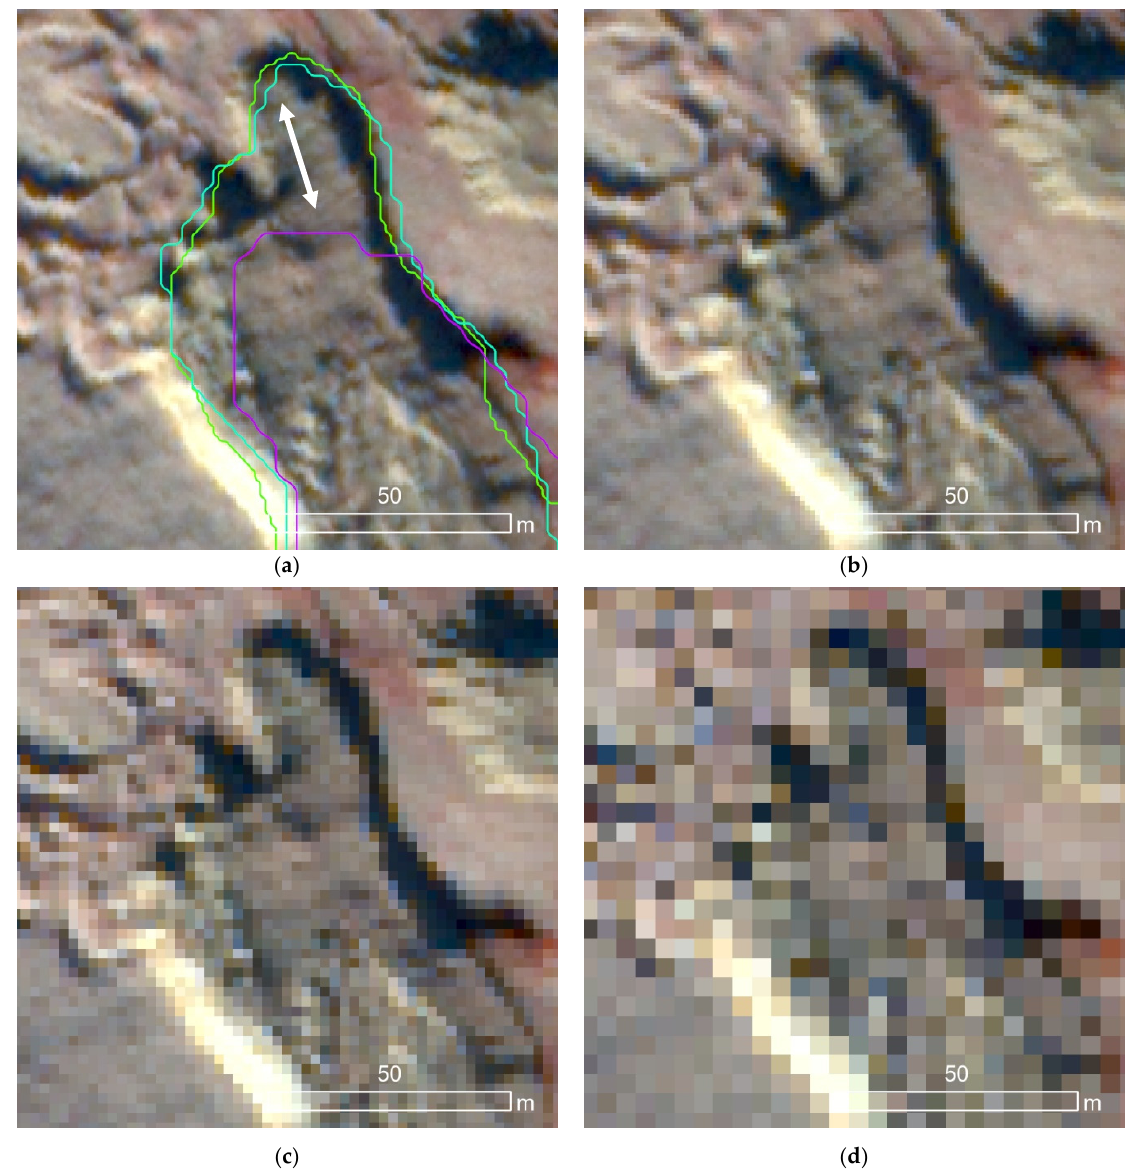
Figure 21. Fluctuation of the model-predicted RTS boundary (here zoomed into headwall of the RTS) with respect to image resizing factor (spatial resolution degradation). ( a ) Model-predicted boundaries when the original image tile (2048 × 2048) is resized to match the network input sizes of 1024 × 1024 (green outline), 512 × 512 (cyan outline), and 256 × 256 (purple outline). Visuals of corresponding resized images are shown in ( b – d ). Underlying imagery are shown in false color composites. ( a ) DLCNN model response to resizing scenario of 2048 × 2048 to 1024 × 1024 (green outline), 2048 × 2048 to 512 × 512 (cyan outline) and 2048 × 2048 to 256 × 256 (purple outline). ( b ) Resized input image tile at 1 m resolution (1024 × 1024). ( c ) Resized image tile at 2 m resolution (512 × 512). ( d ) Resized image input tile at 4 m resolution (256 × 256).